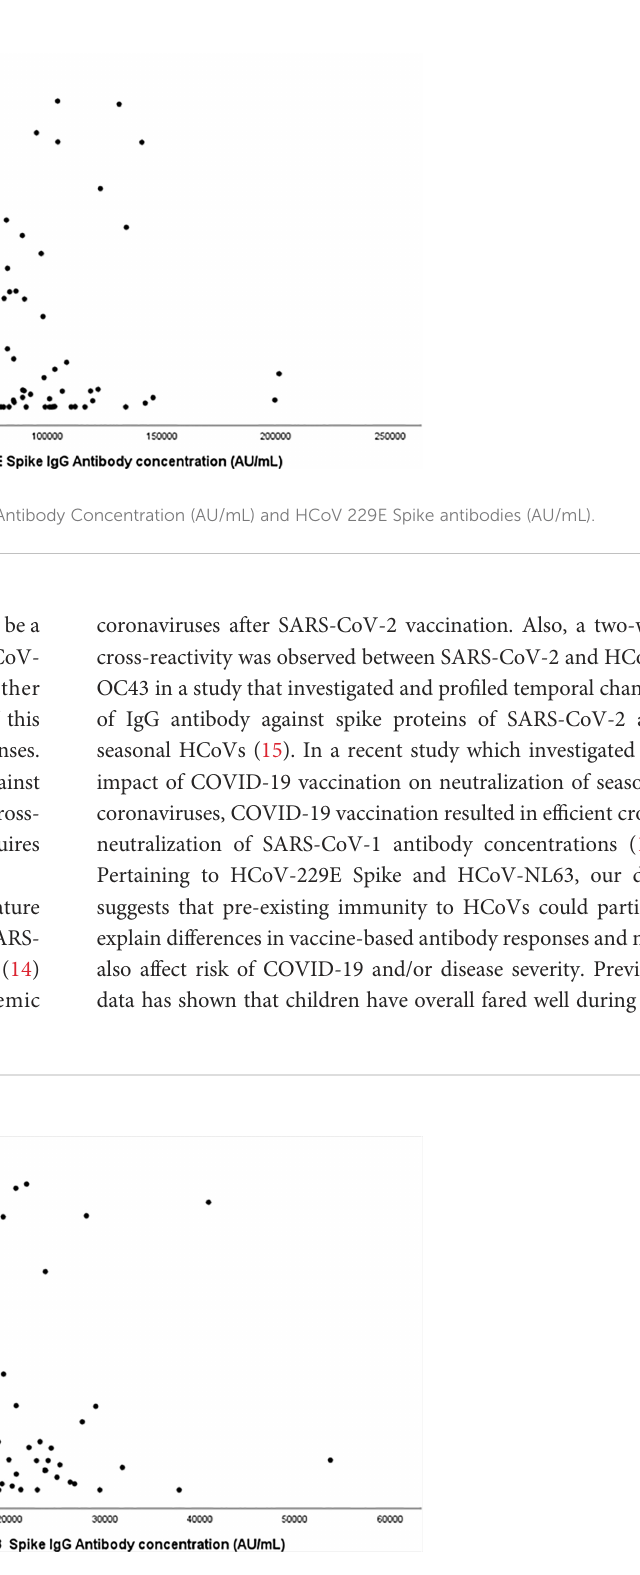
FIGURE 2 Scatter plot depicting relationship between SARS-CoV-2 Spike Antibody Concentration (AU/mL) and HCoV NL63 Spike antibodies